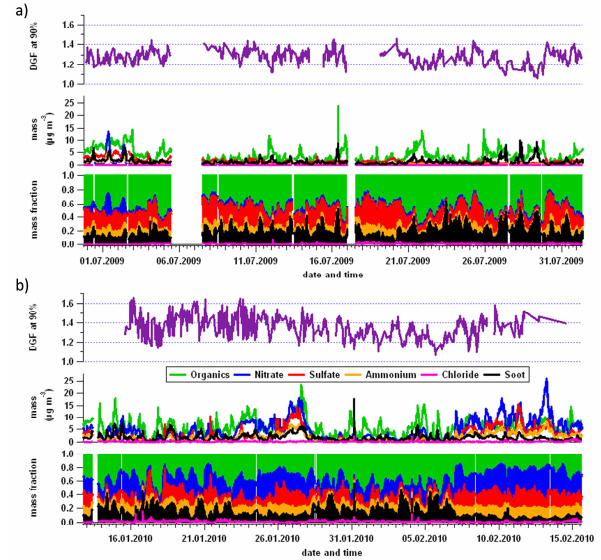
Fig. 2. Time series of the DGF of 285nm particles at a RH of 90% Figure 2. Time series of the DGF of 285nm particles at a RH of 90% and the particle 3 and the particle compounds measured with AMS and MAAP for compounds measured with AMS and MAAP for summer (a) and winter (b). 4 summer (a) and winter (b)